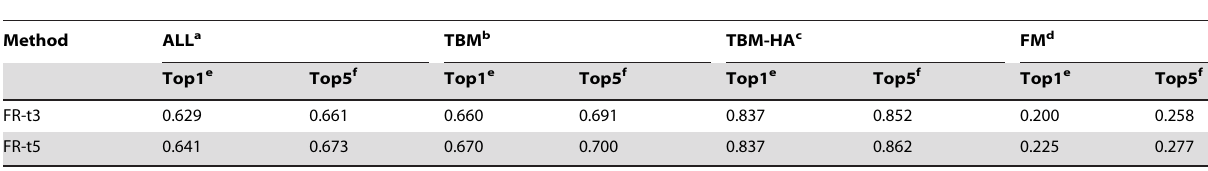
Table 3. The comparison of FR-t5 and FR-t3 on CASP8 test set.